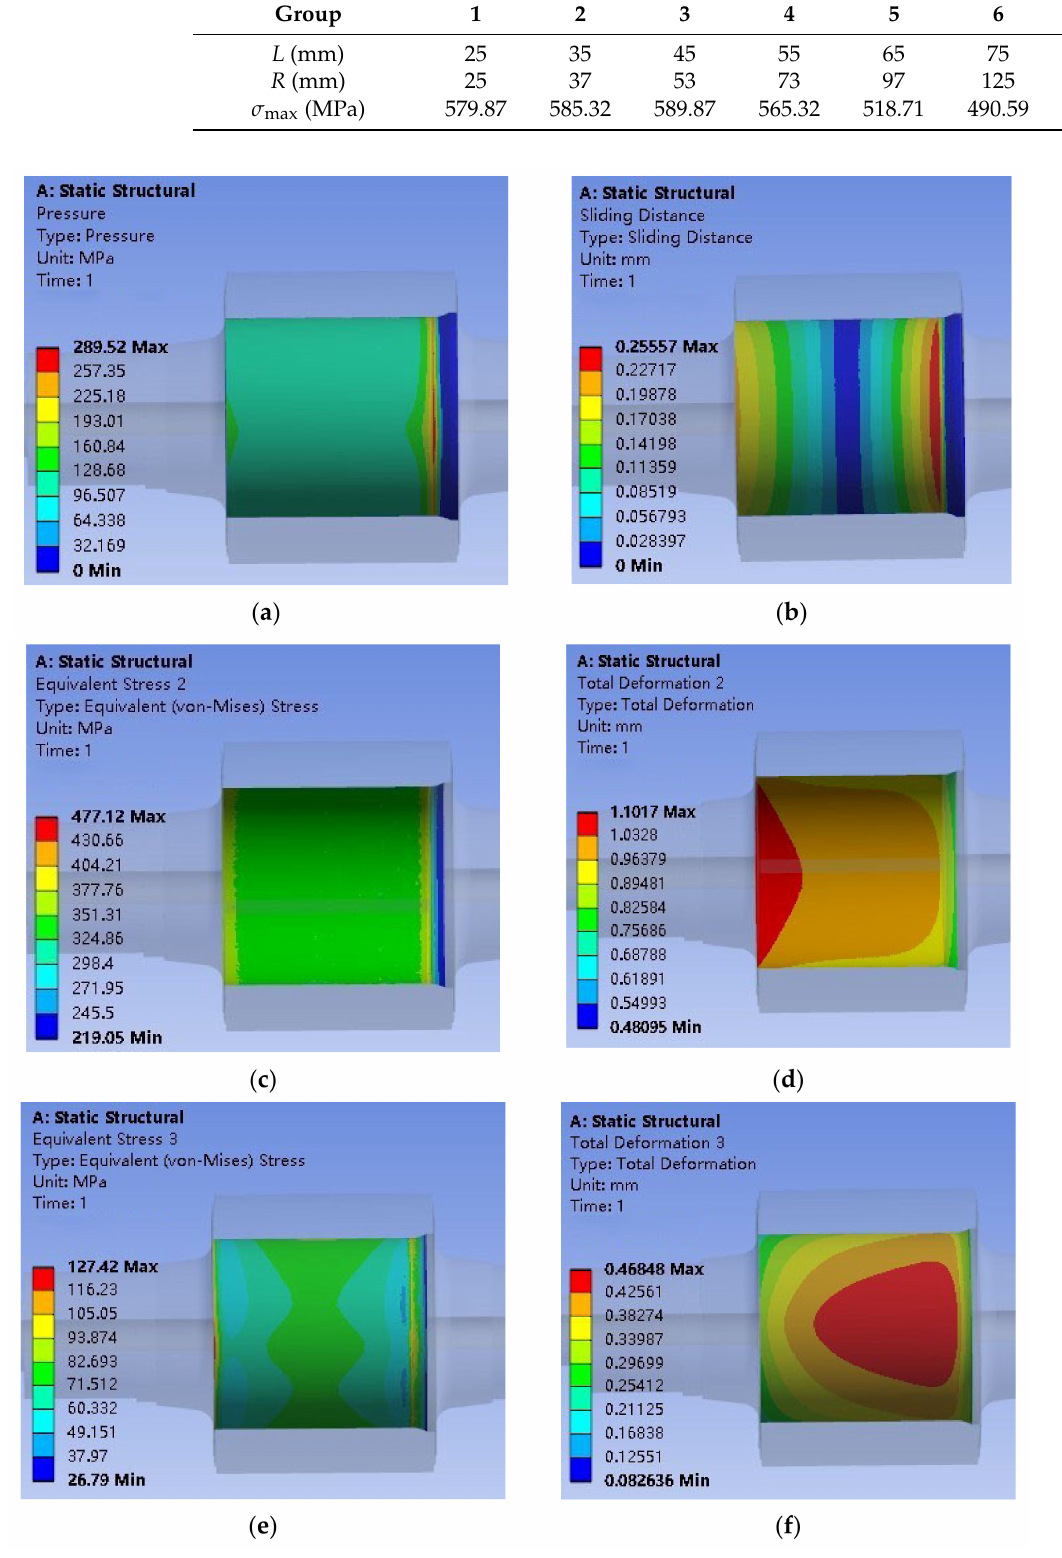
Figure 14. Simulation results of the improved structure: ( a ) contact stress nephogram; ( b ) sliding distance nephogram; ( c ) equivalent stress nephogram of roller sleeve; ( d ) deformation nephogram of roller sleeve; ( e ) equivalent stress nephogram of roller shaft; ( f ) deformation nephogram of roller